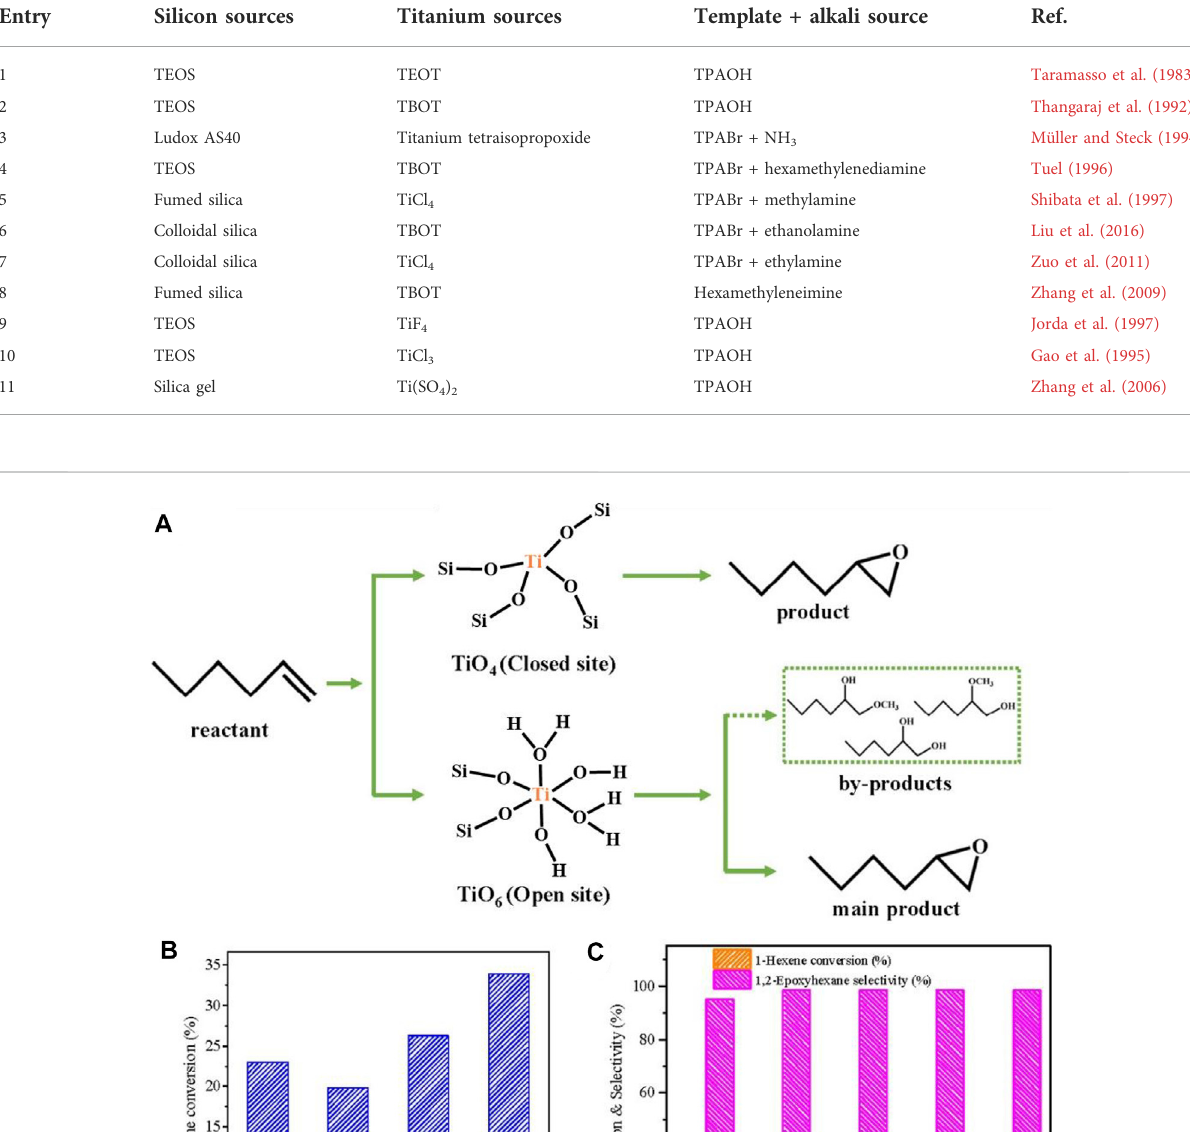
TABLE 1 Overview of the synthesis of TS-1 zeolites using various raw materials.